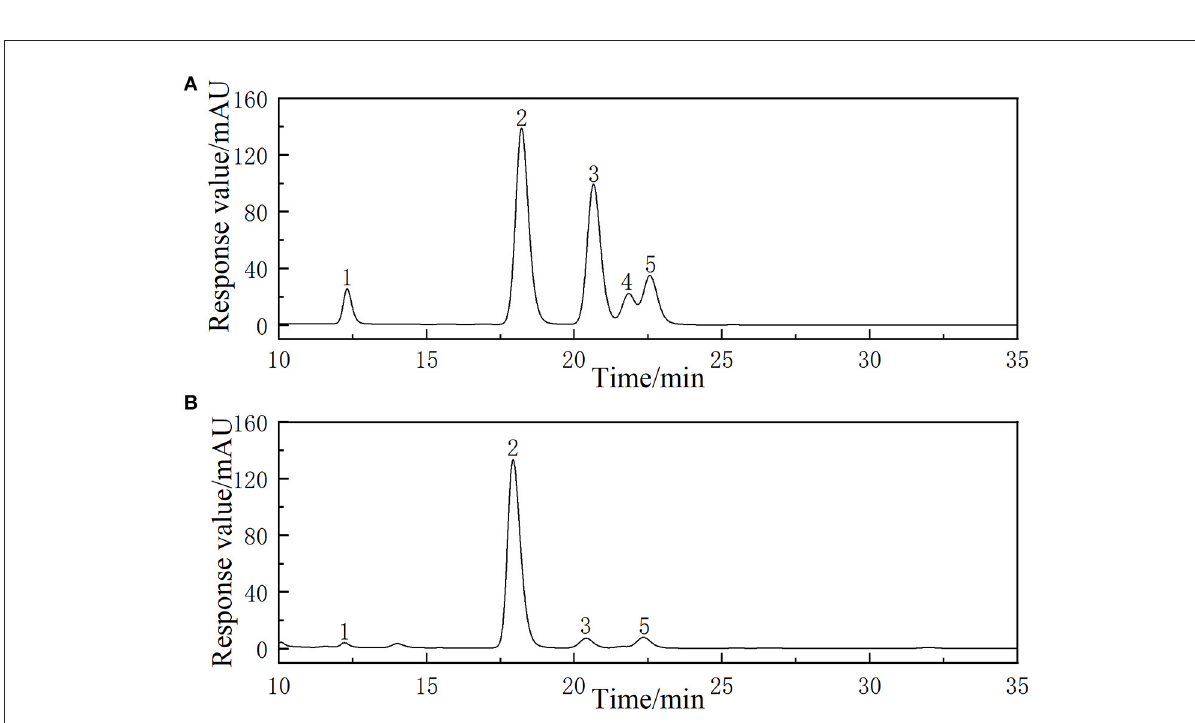
FIGURE5 HPLC chromatogram of reference monosaccharides (A) and monosaccharides composition of LLPs (B) .